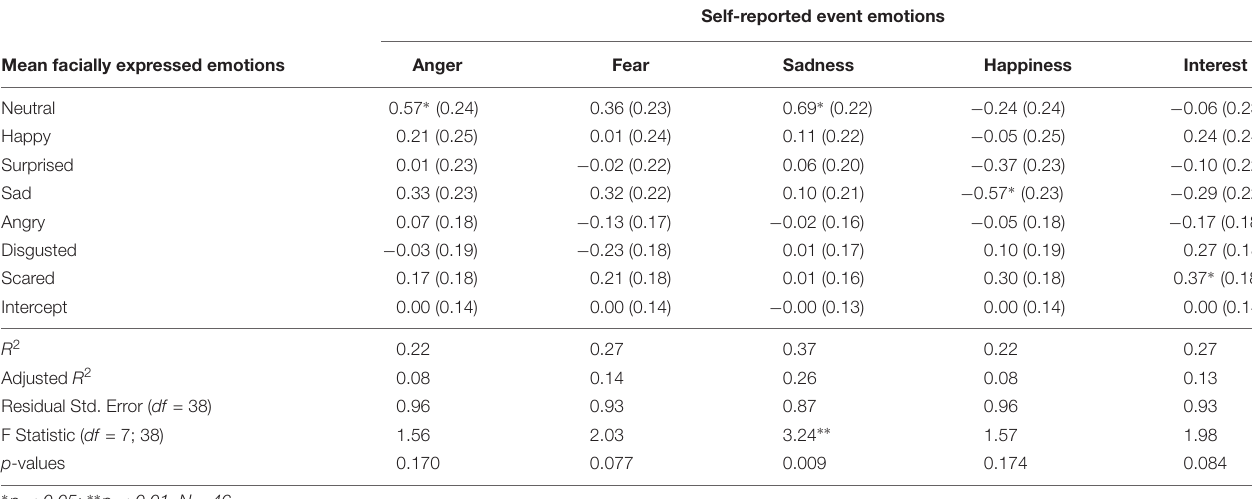
TABLE 3 | Standardized regression coefficients ( β ), standard errors (in parenthesis) and overall statistics for five models predicting self-reported event emotions by the means of the facially expressed emotions.